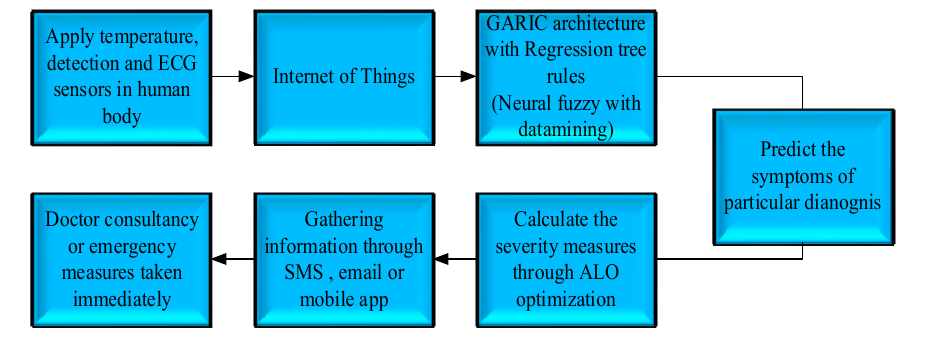
Figure 3. Proposed methodology.